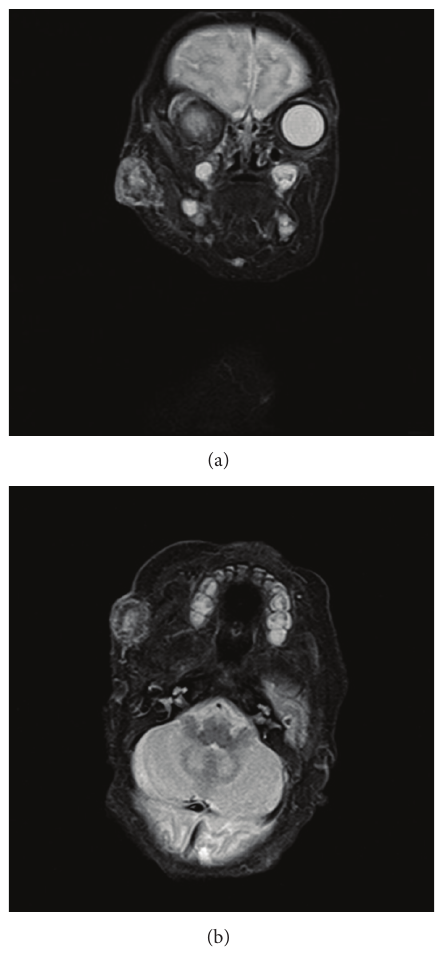
Figure 2: (a) Coronal MRI at 11 days. (b) Axial MRI at 11